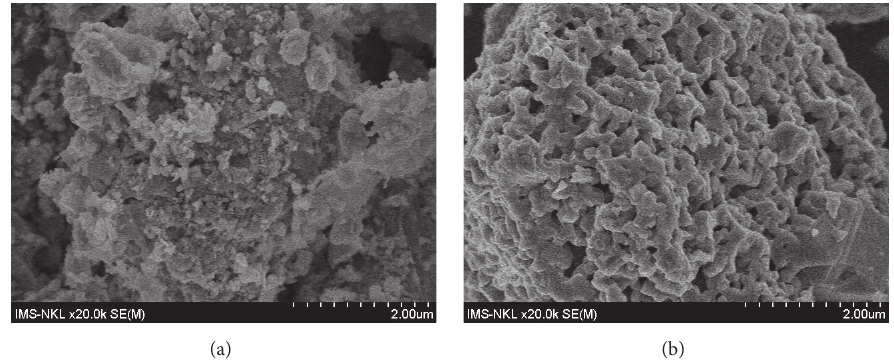
Figure 1: Scanning electron microscopy (SEM) image of Pyrolusite ore, (a) natural Pyrolusite ore, and (b) La 3+ -doped Pyrolusite ore at La 3+ /Fe 3+ molar ratio of 1:1.